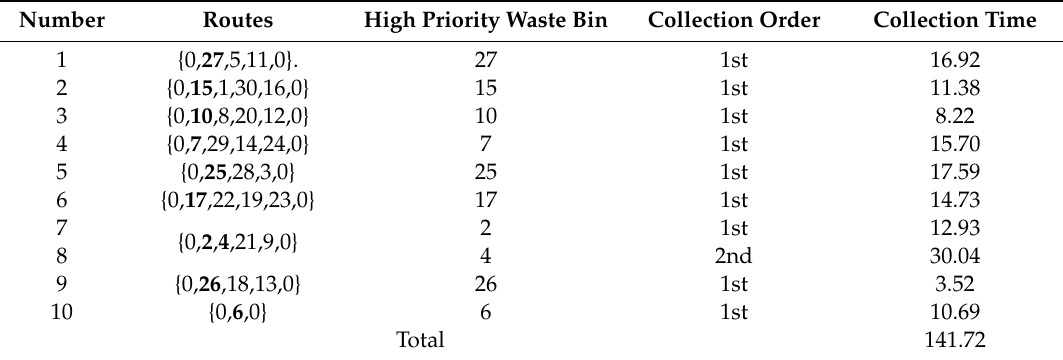
Table 13. Detailed route information under priority considered scenario (PCS).